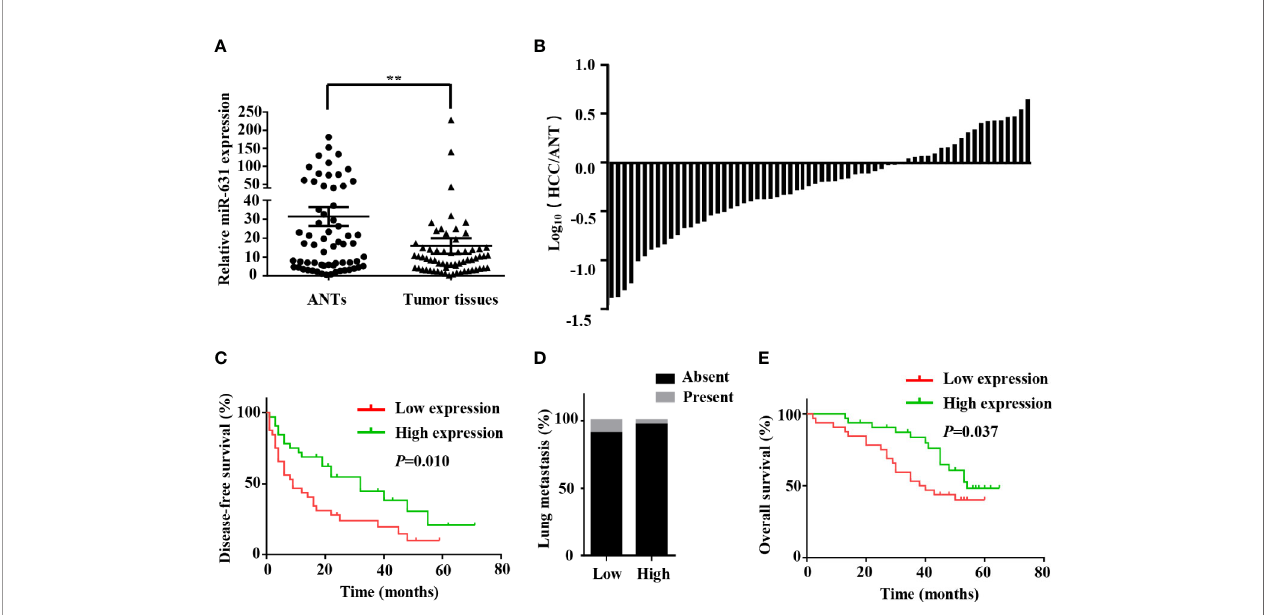
FIGURE 1 | miR-631 is downregulated in tumor tissues of HCC. (A) miR-631 expressions in 64 paired HCC tissues and ANTs, measured by qRT-PCR and unit of U6. The data were analyzed by the delta Ct method on a logarithmic scale and compared by paired Student ’ s t-test. (B) The bars represent relative miR-631 expression with the ratio of its level in HCC tissue versus ANT in a logarithmic scale of 64 paired HCC patients. (C) Kaplan – Meier survival curves showed that the expression of miR-631 was associated with the disease-free survival of HCC. (D) There is no signi fi cant difference between the expression of miR-631 and lung metastasis. (E) The expression of miR-631 was associated with the overall survival of HCC analyzed by Kaplan – Meier survival curves. **P < 0.01.